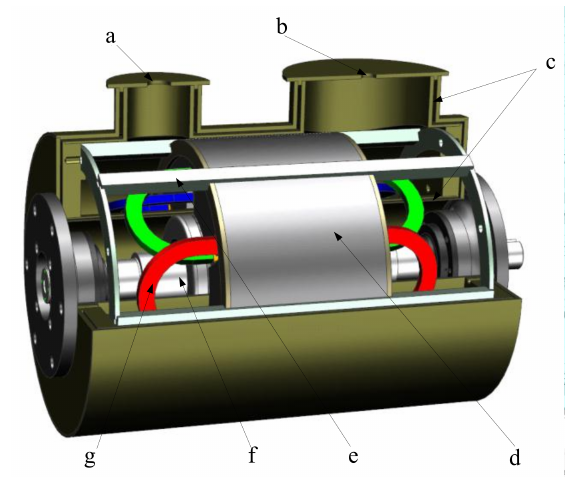
Figure 9. Illustrations for the possible cryogenic system structure with the complete motor; (a) liquid nitrogen inlet hole, (b) pumping hole; (c) thermal insulation layer; (d) stator part; (e) support frame; (f) rotor part and (g) HTS